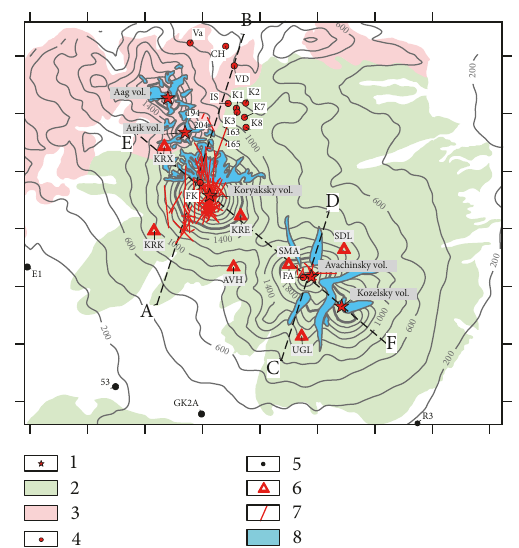
Figure 1: Geological map of the Koryaksky-Avachinsky vol- canogenic basin. ( 1 ) The summits of the Avachinsky, Koryaksky, Kozelsky, Arik, and Aag volcanoes; (2) Avachinsky, Koryaksky, Kozelsky volcanoes, and their eruptive products; (3) Pinachevsky extrusions Q 2 ; (4) thermal features (for details, see Table 1): FA, - 3 fumaroles on Avacha Volcano; FK, fumaroles on Koryaksky Vol- cano; K1, K2, K3, K7, and K8, thermal mineral springs of Koryaksky Narzan; IS, Izotovsky; VD, Vodopadny; CH, Chistinsky; Va, Vakin- sky; (5) deep hydrogeological wells; (6) KB GS RAS seismograph stations; (7) dikes traced at − 3000 masl below Koryaksky Volcano and 1500 masl below Avachinsky Volcano; (8) glaciers. Notes: ( 1 ) the isolines show the topographic surface, and the ticks along the axes represent intervals of 5 km. (2) For the extended map, including positions of all deep wells, see Figure 1 in Kiryukhin et al.